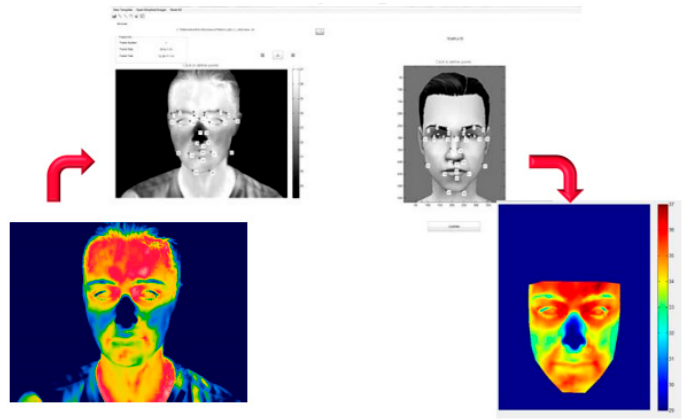
Figure 2. Example of morphing system.